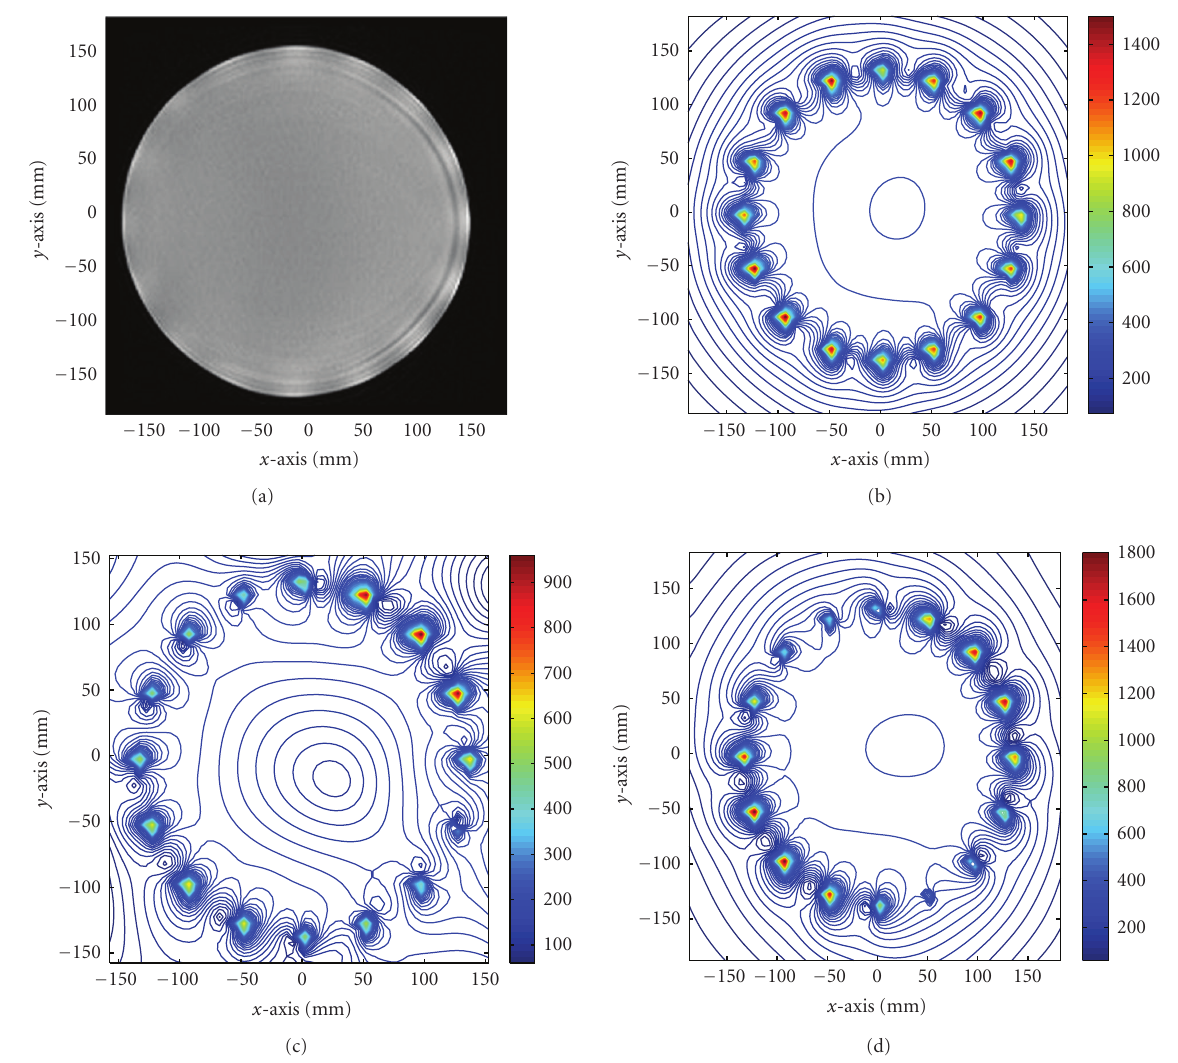
Figure 6: Measurement of homogeneity of B 1 field. (a) Acquired MR image of an oil phantom loaded within the coil. (b) Calculated B 1 -map after 40-cycle iterations with N p = 10 and N s = 10. The homogeneity of B 1 -map is good inside, on the surface of, and outside of the coil. (c) Calculated B 1 -map after 40-cycle iterations with N p = 10 and N s = 1. The homogeneity of B 1 -map is unacceptable. (d) Calculated B 1 -map after 120-cycle iterations with N p = 10 and N s = 10. The intensities of the B 1 field at the left-bottom corner and right-top corner are higher than those at other corners.